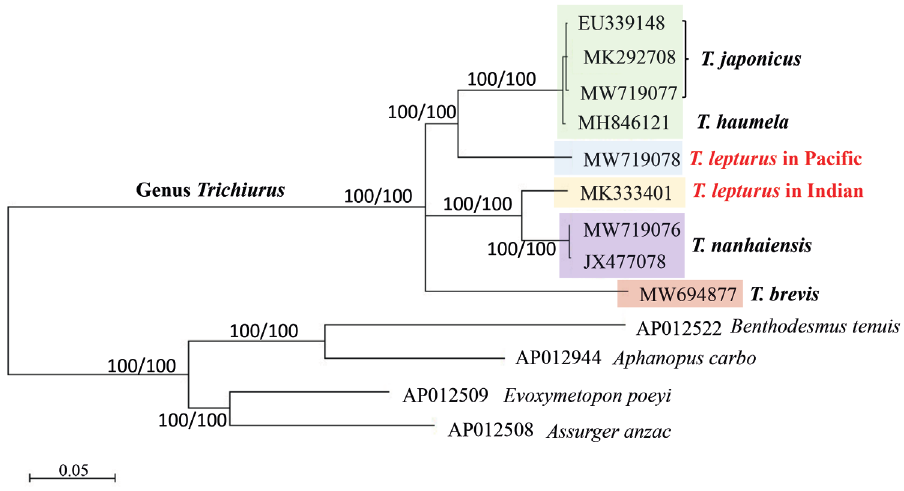
Figure 3. The maximum-likelihood (ML) tree of the Trichiuridae based on the sequences of mitogenome (ex- cluding d-loop). The numbers at the nodes are bootstrap values of the ML and NJ (neighbor-joining) analyses.